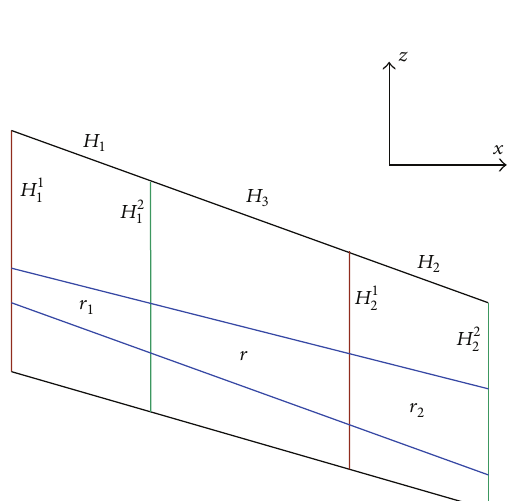
Figure 3: The illustration of the connection with respect to 𝐻 1 and 𝐻 2